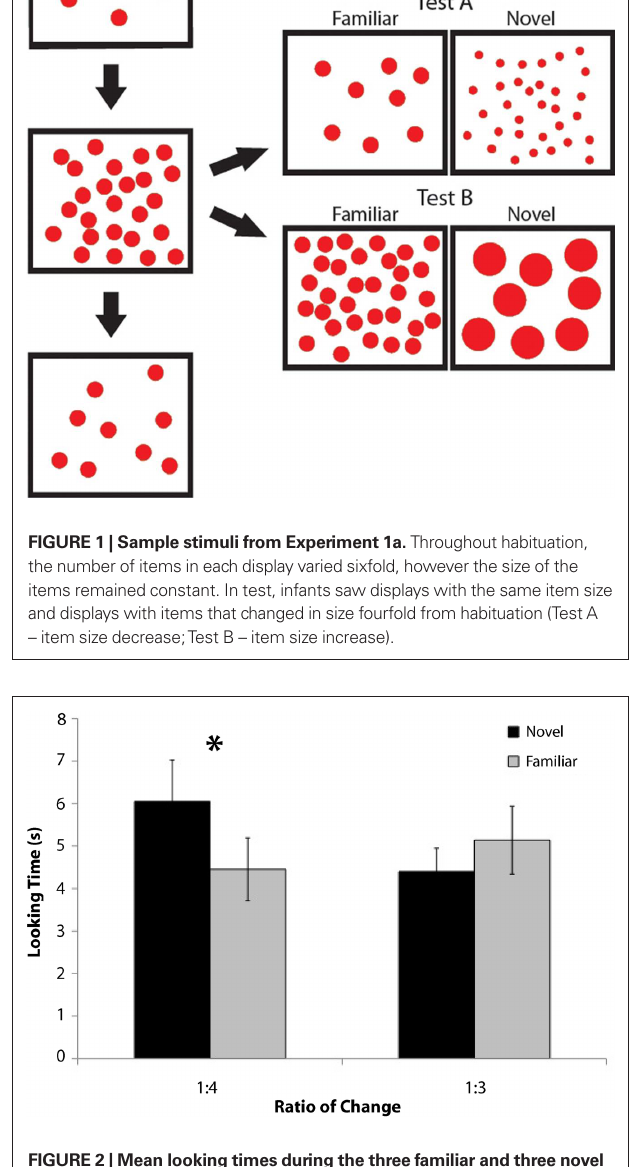
Figure 2 | Mean looking times during the three familiar and three novel test trials for infants in experiment 1 (variable number in